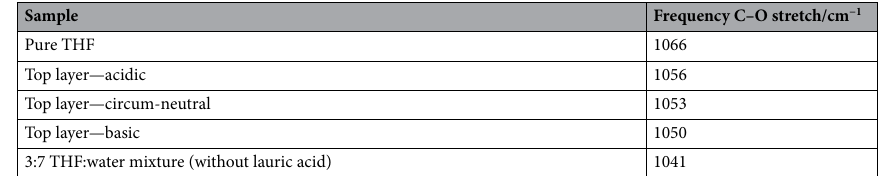
Table 6. Frequency of the C–O stretch of THF for each sample, prepared either with or without 1 M lauric acid. In the table, the rows labelled as ‘top layer’ refer to the top layer of 3:7 THF:water (v/v) mixtures separated with 1 M lauric